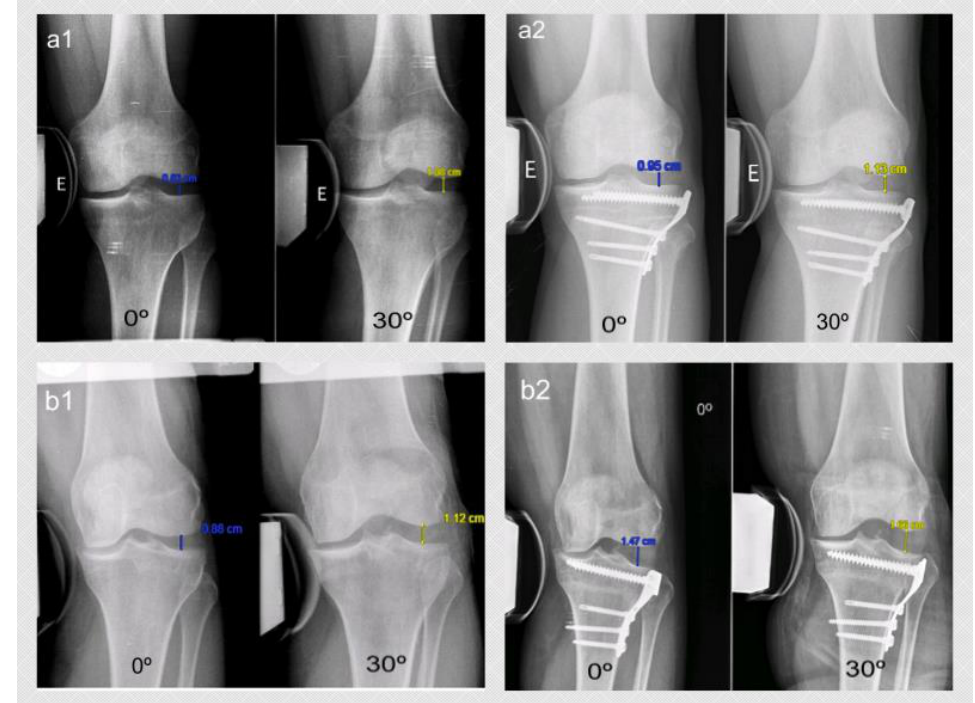
Figure 2. Varus-stress radiological image at full extension and 30° of knee flexion in a patient randomized to Group 1 ( a1 pre-op; a2 post-op) and in Group 2 ( b1 pre-op; b2 post-op). The measurement was done between the central aspect of the lateral femoral condyle and the corresponding lateral tibial plateau.